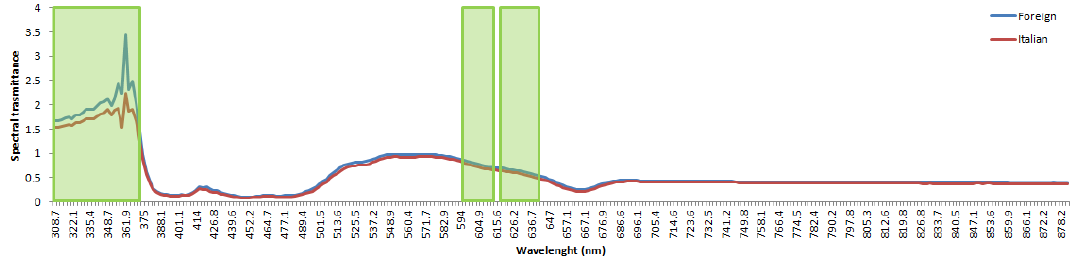
Figure 5. Mean VIS-NIR spectral data: Italian (red line), foreign (blue line). Higher importance spectral values extracted with the MANOVA rotation test are evidenced with green rectangles.